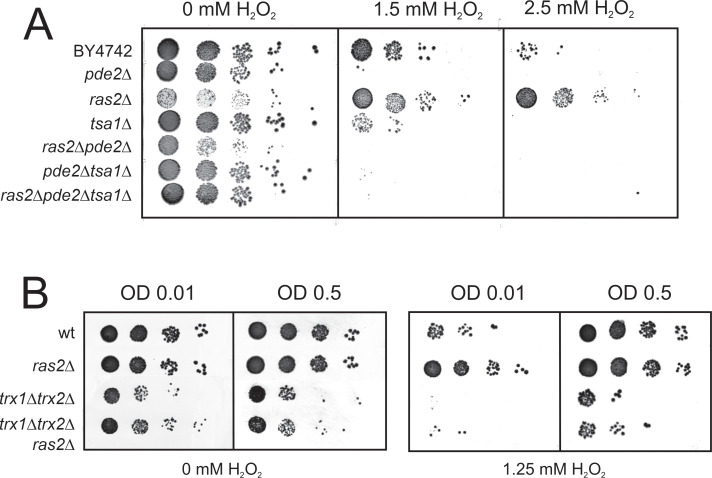
Reduced Ras activity can overcome H2O2 sensitivity of cells lacking Tsa1 but not that of cell lacking the cytosolic thioredoxins Trx1 and Trx2.(A) H2O2 resistance in the indicated mutant strains strains grown to mid exponential phase (OD 0.3) and spotted onto plates with or without the indicated amounts of H2O2. (B) H2O2 resistance in the indicated mutant strains strains grown to early (OD0.01) and mid exponential phase (OD0.5) and spotted onto plates with or without the indicated amounts of H2O2.